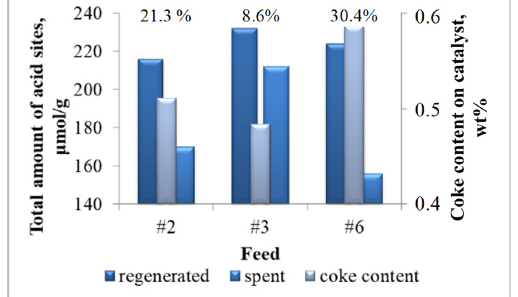
Figure 5. Dependence of total amount of desorbed ammonia from the catalyst surface on the content of coke on the catalyst.